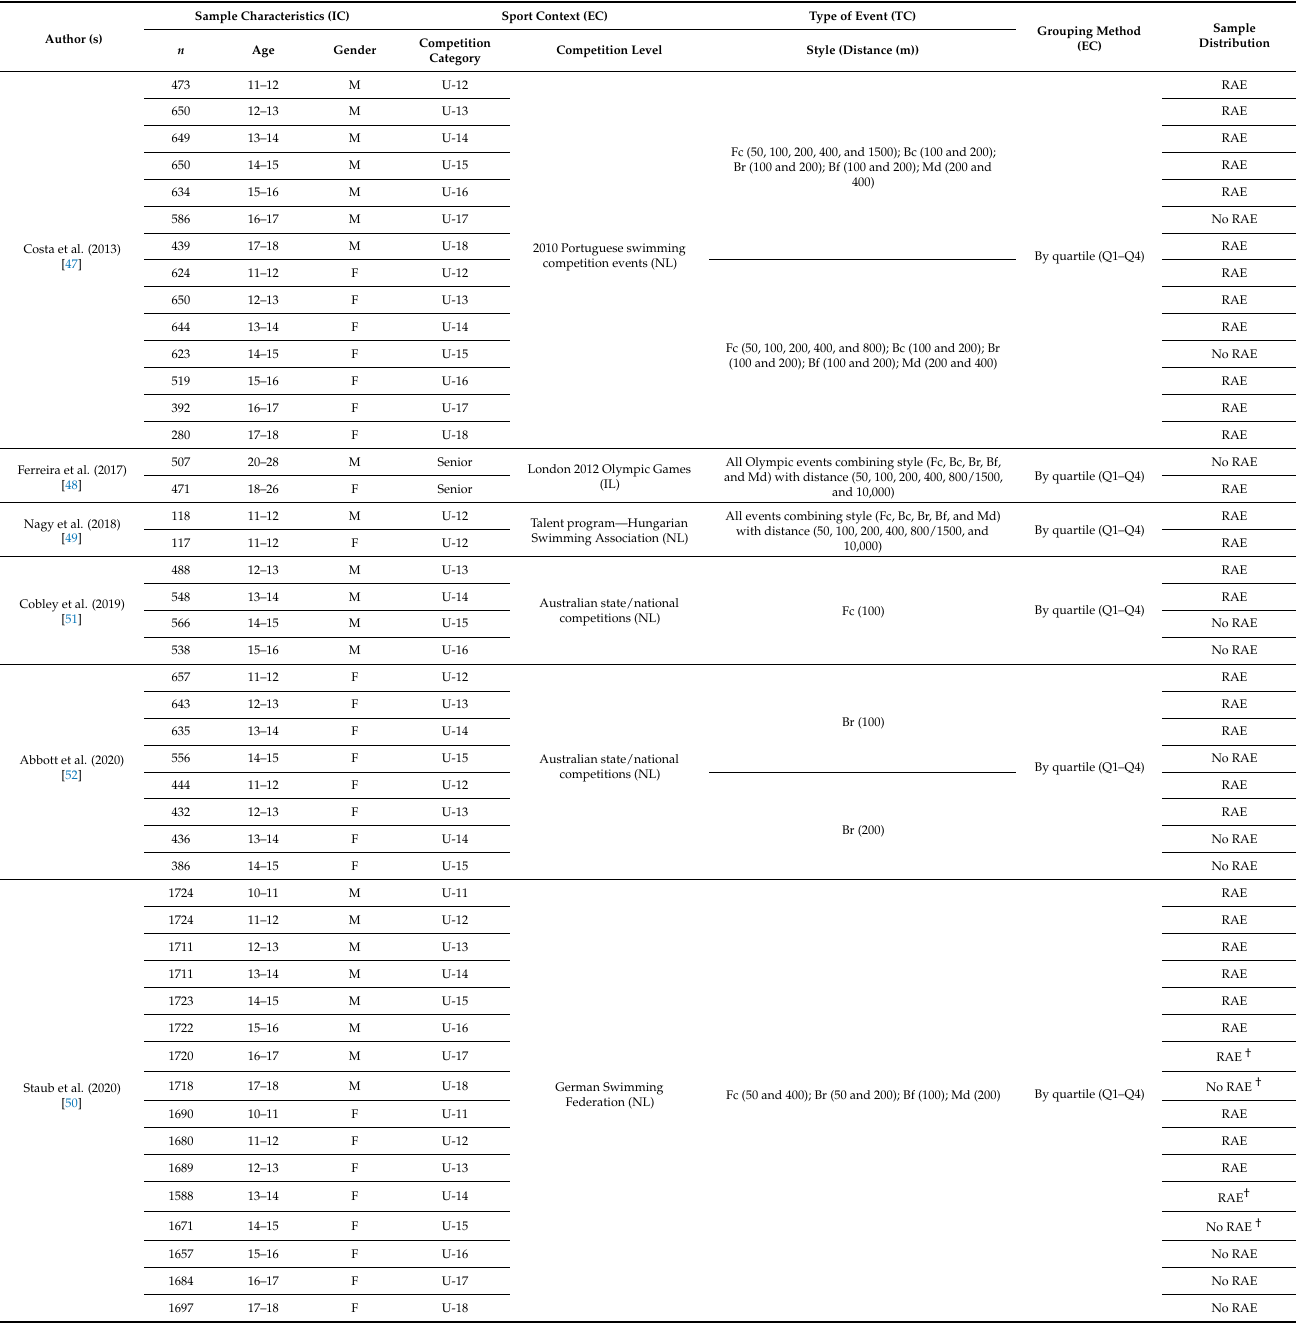
Table 1. Distribution of the sample according to the characteristics of the swimmers, sport context, grouping method, and sample distribution based on